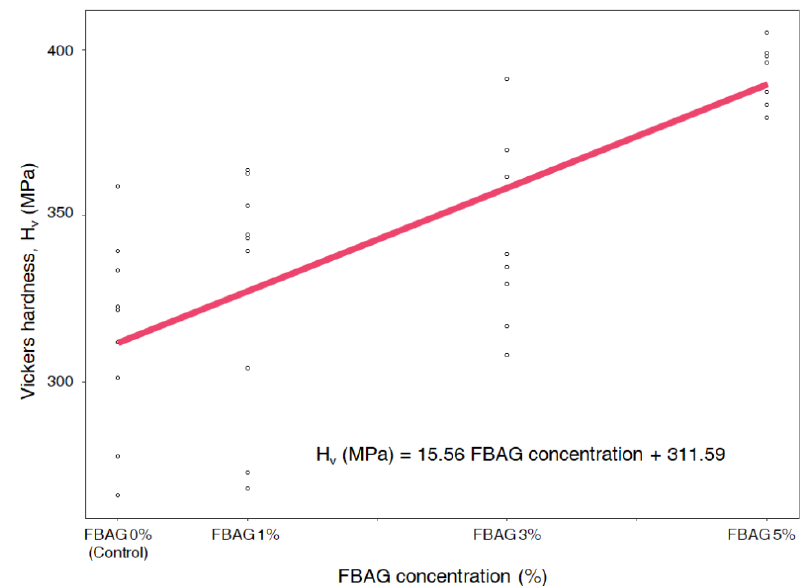
Figure 4. Correlation between concentration of FBAG and Vickers hardness in resin disk (r = 0.54; p < 0.001).